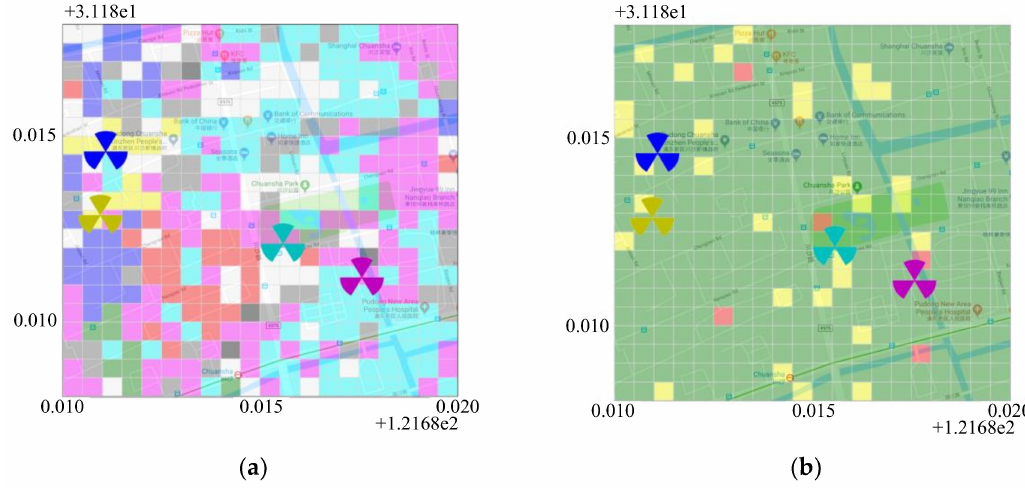
Figure 16. ( a ) Coverage identification of target area, ( b ) Cross-operators comparison of